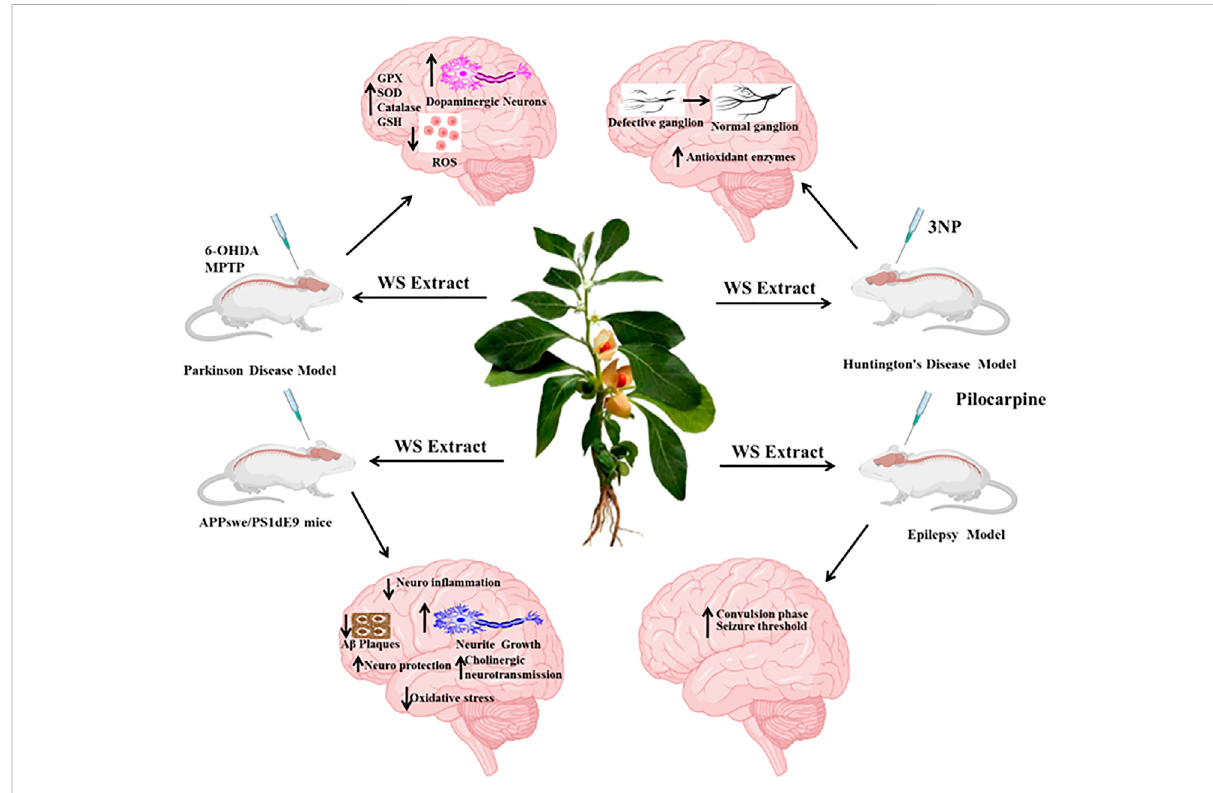
FIGURE 4 Effect of Withania somnifera on different neurodegenerative